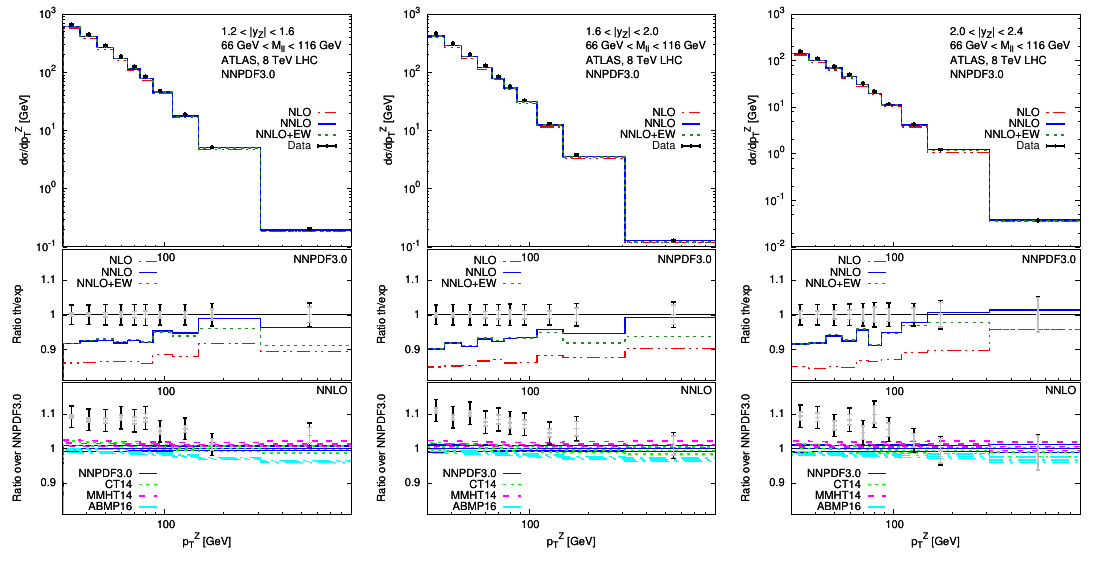
Figure 5 . Same as (cid:12)gure 4 for the three more forward rapidity bins.